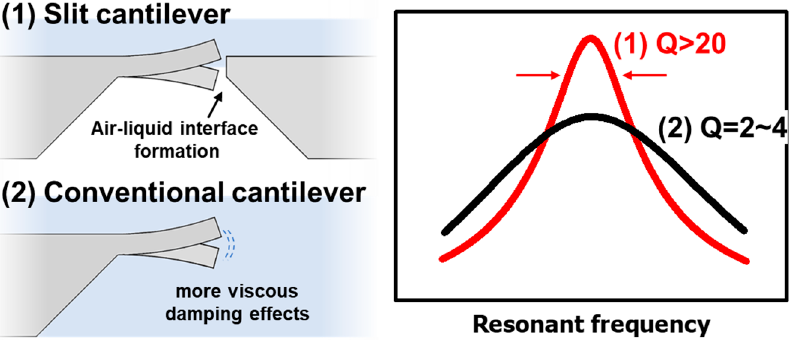
Figure 1. Schematic illustration of slit cantilever compared to the conventional structure of cantilever sensors in liquid environment and a conceptual diagram showing an enhanced quality-factor of the slit cantilever by reducing viscous damping due to formation of the air-liquid interface.